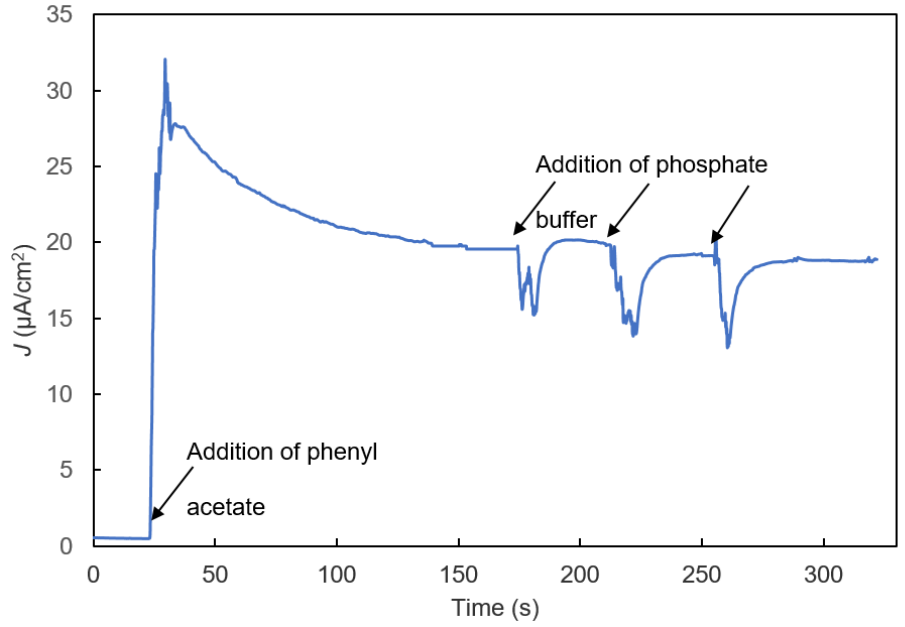
Figure 6. Current vs. time response of the bi-enzyme biosensor to the addition of phenylacetate (S 1 ) to obtain a final phenylacetate (S 1 ) concentration of 0.9 mM followed by the addition of inhibitor PMSF to obtain a final PMSF concentration of 0.17 mM.